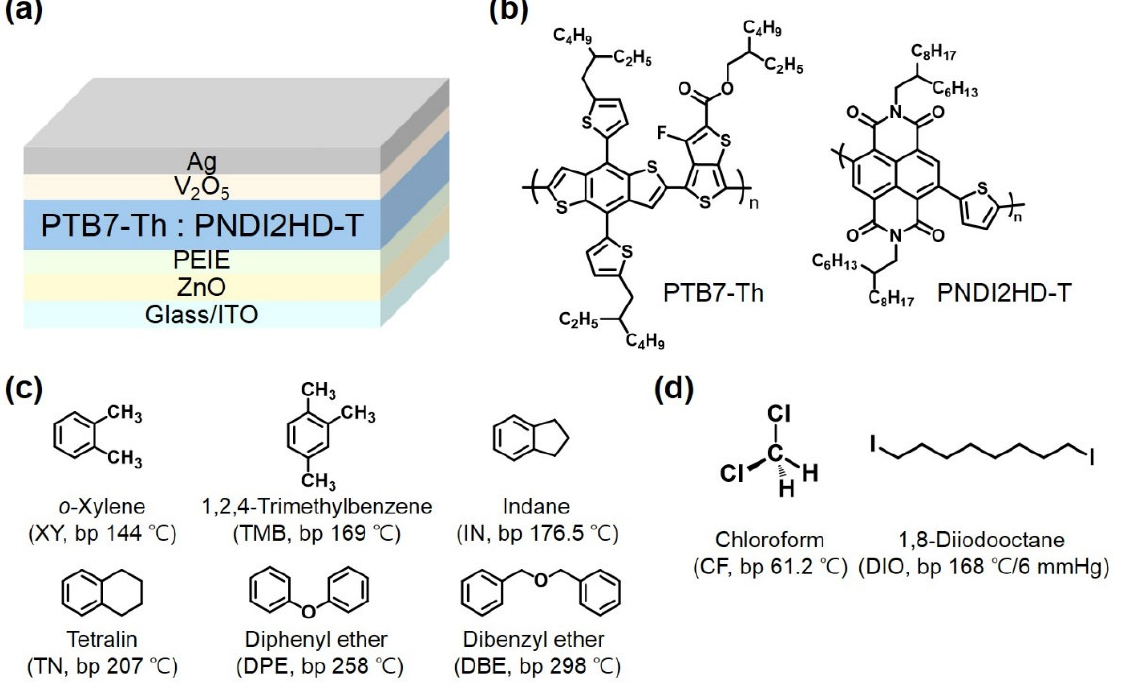
Figure 1. ( a ) Schematic drawing of inverted device structure; ( b ) chemical structure of PTB7 ‐ Th ( p ‐ type polymer) and PNDI2HD ‐ T ( n ‐ type polymer); ( c ) chemical structure of non ‐ halogenated sol ‐ vents used in this study; ( d ) chemical structure of halogenated solvents used in this